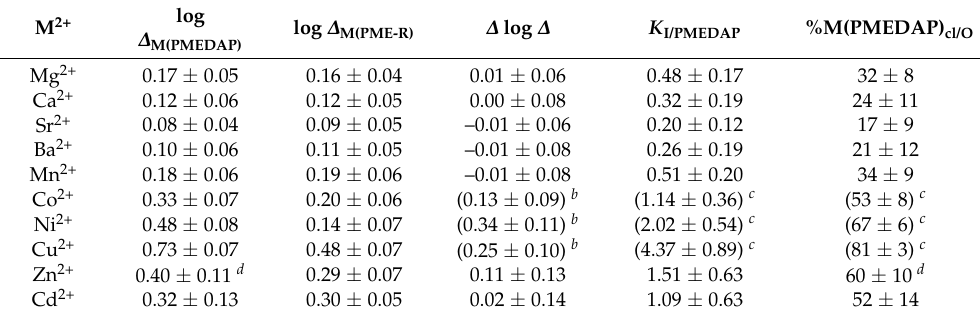
Table 4. Stability enhancements (Equation (12)) for the M(PMEDAP) and M(PME-R) complexes and their comparison according to Equation (13). In addition, the extent of chelate formation according to Equilibrium (5) is given as expressed by the dimension-less equilibrium constant K I (Equations (6) and (10)) and the percentages of M(PMEDAP) cl/O (Equation (14)). (Aqueous solution; 25 ◦ C; I = 0.1 M, NaNO 3 ) a